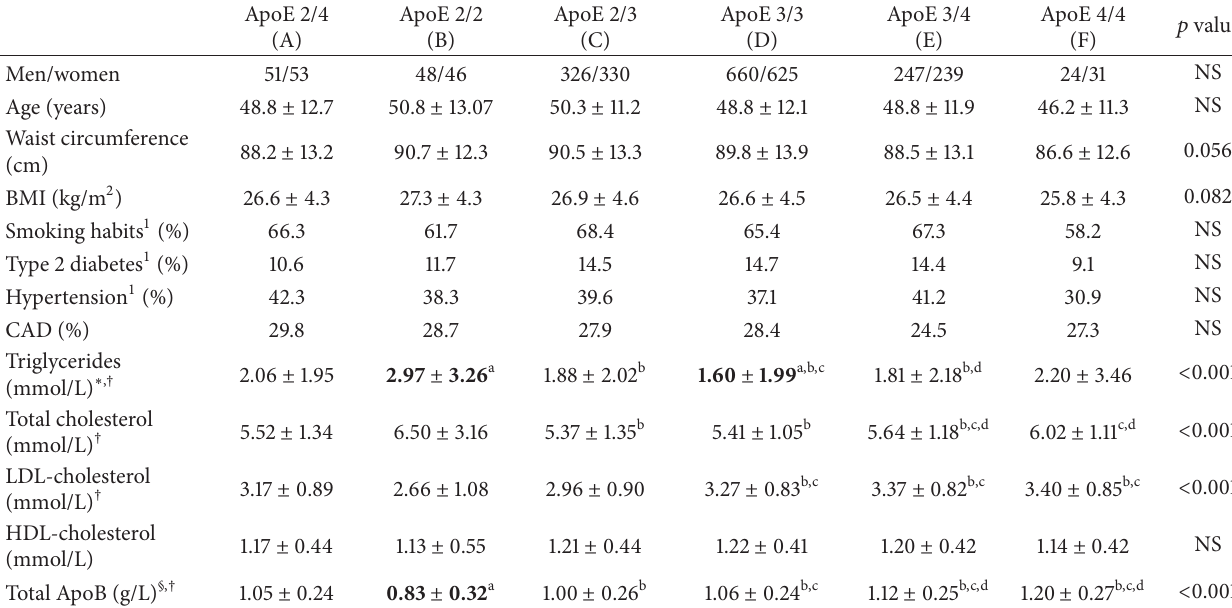
Table 2: Subjects’ characteristics according to the apolipoprotein E